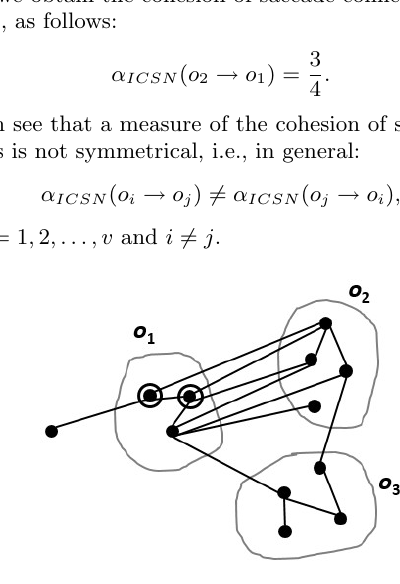
Figure 4: Nodes belonging to the lower approxima- tion ICSN ( o 1 → o 2 ) of the inter-component saccade neighborhood, from o 1 to o